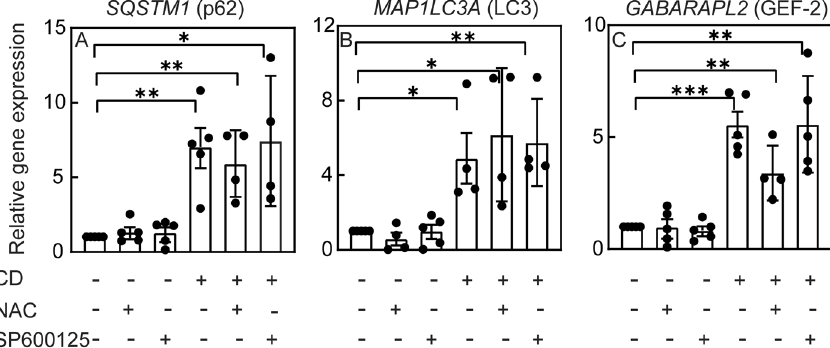
Fig. 7 The increased transcription of autophagy markers following cholesterol depletion is independent of ROS and of JNK activity. Mv1Lu cells were treated (or not) for CD by statin (16 h) with or without NAC (10 mM) or SP600125 (20 μ M). RT-qPCR was as described under “ Materials and methods ” . Data (mean ± SEM; 4 – 5 independent experiments in each case) were normalized to the cDNA levels of β -actin, taking the level of the respective mRNA in untreated cells (control) as 1. The mRNA levels were signi fi cantly elevated in cholesterol-depleted cells under all conditions (* P < 0.05; ** P < 0.01; *** P < 0.001; Student ’ s two-tailed t -test). Cell Death Discovery (2021)